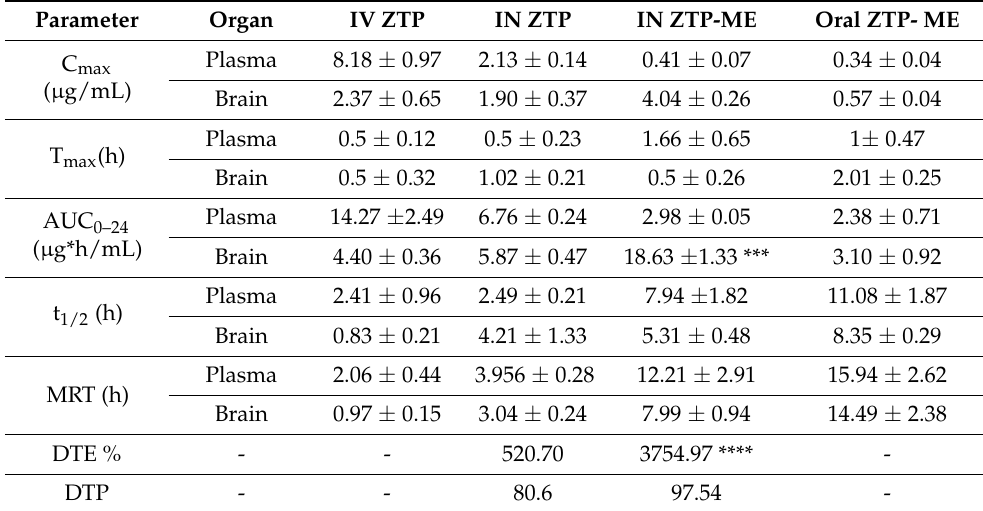
Table 4. In vivo pharmacokinetic parameters after administration of ZTP and ZTP ‐ ME.